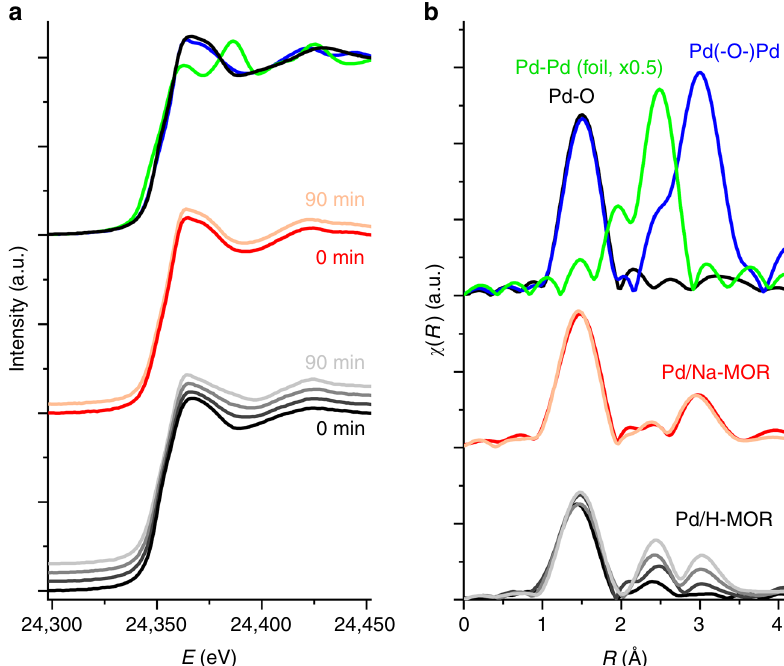
Fig. 3 In situ X-ray absorption spectroscopy of catalyst aging. a X-ray absorption near-edge structure (XANES) spectra and b the corresponding Fourier transforms of in situ Pd K-edge extended X-ray absorption fi ne structure (EXAFS) spectra (non-phase shift corrected) of the catalysts after pretreatment (10 min in 1 vol% CH 4 , 4 vol% O 2 , bal. N 2 , GHSV = 350,000h − 1 at 410 °C) and after 15, 30, and 90 min aging in a feed of 1 vol% CH 4 , 4 vol% O 2 , 5 vol% H 2 O, bal. N 2 at 410 °C: Pd/H-MOR (black to light gray); Pd/Na-MOR (red to pink); bulk PdO (blue); calcined Pd/H-MOR (black); and palladium foil (green). The spectra and Fourier transforms are offset for